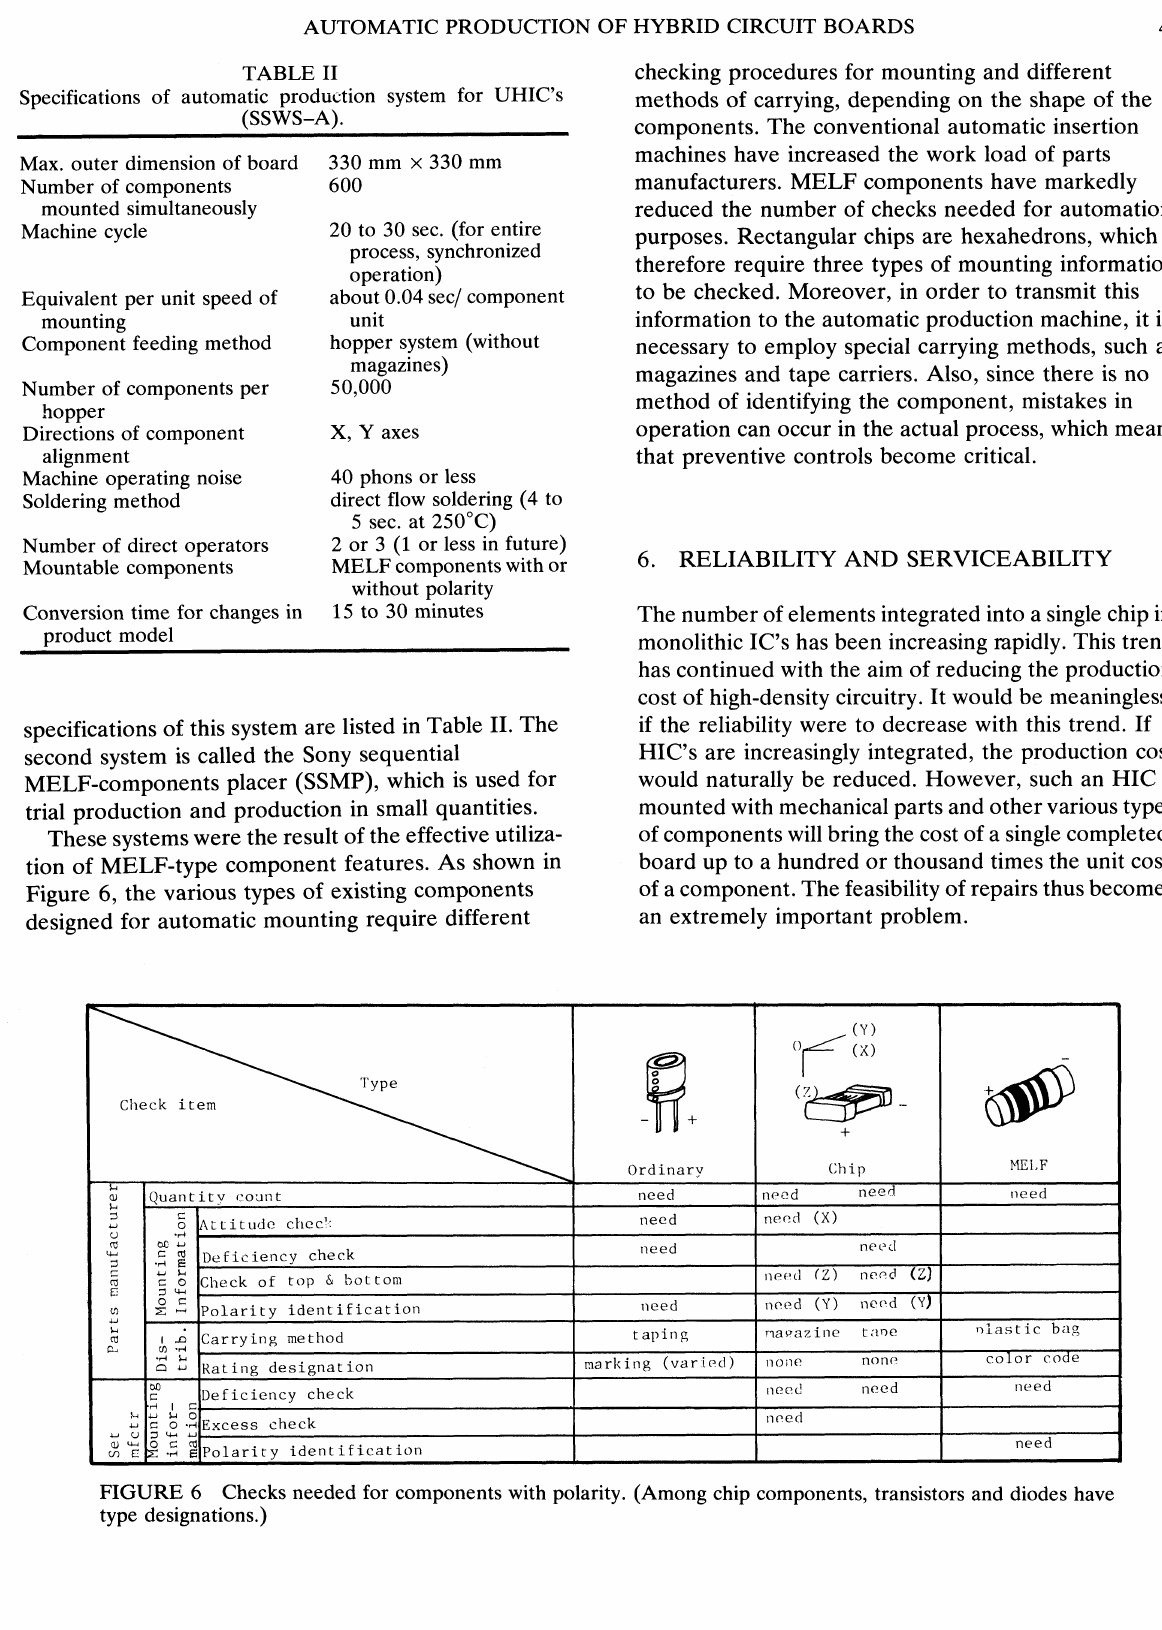
FIGURE 6 Checks needed for components with polarity. (Among chip components, transistors and diodes have type